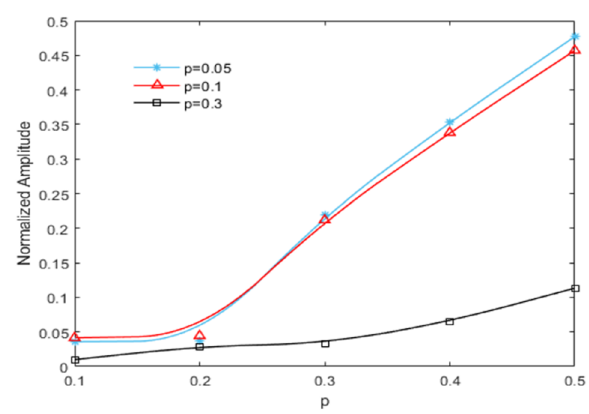
Figure 7. Variation trend of the second harmonic amplitude with crack depth.